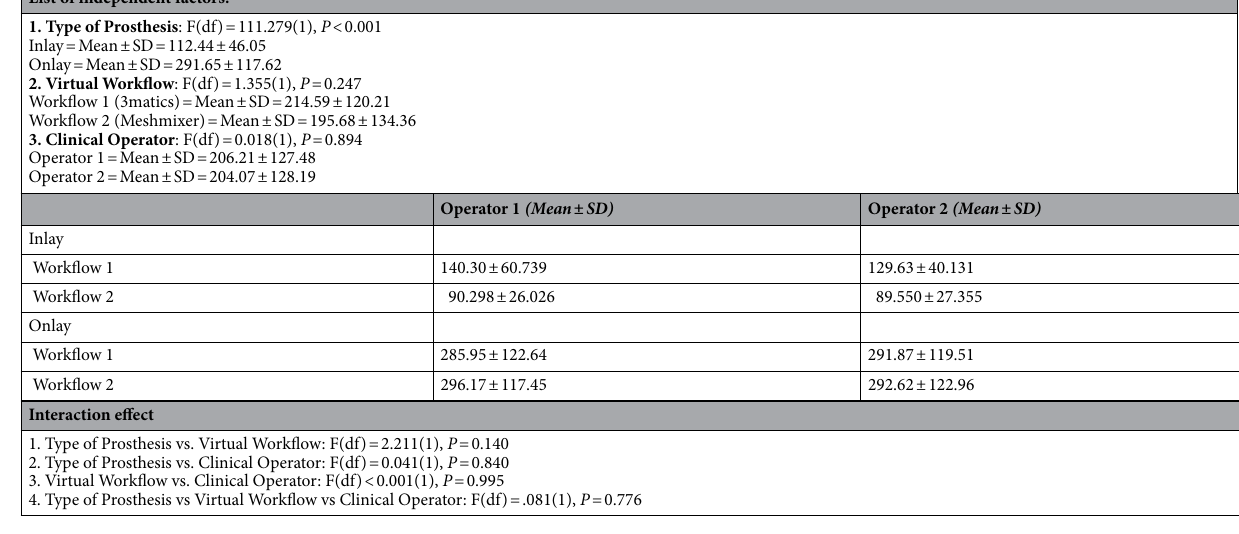
Table 1. Analysis of variance (n = 116) for mesh surface